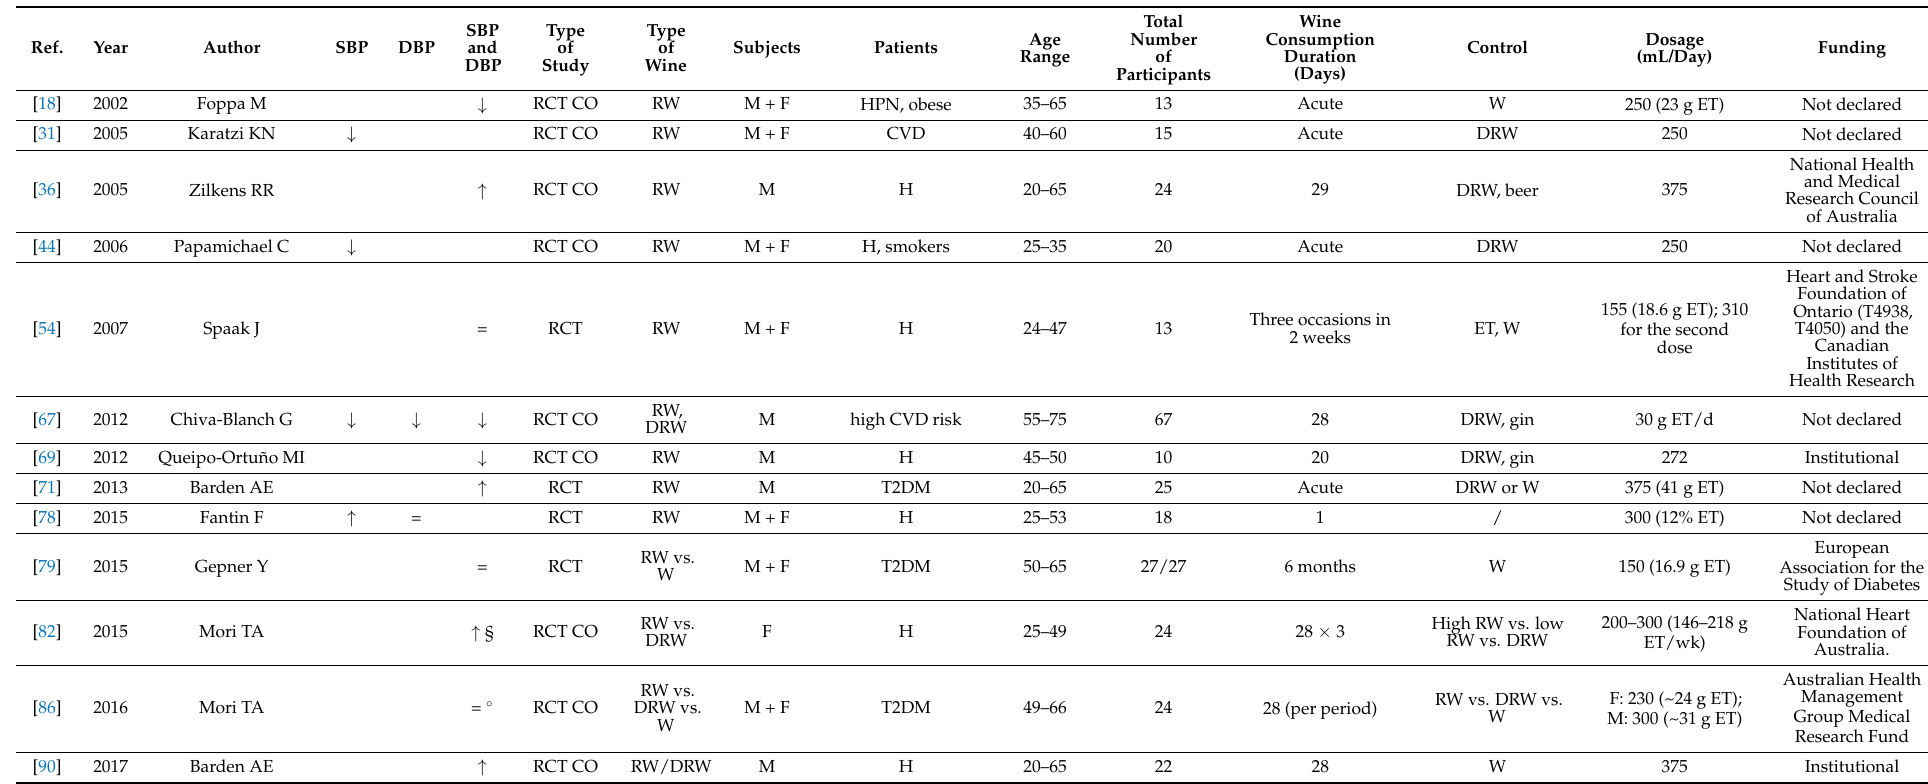
Table 5. Effects of red wine consumption on